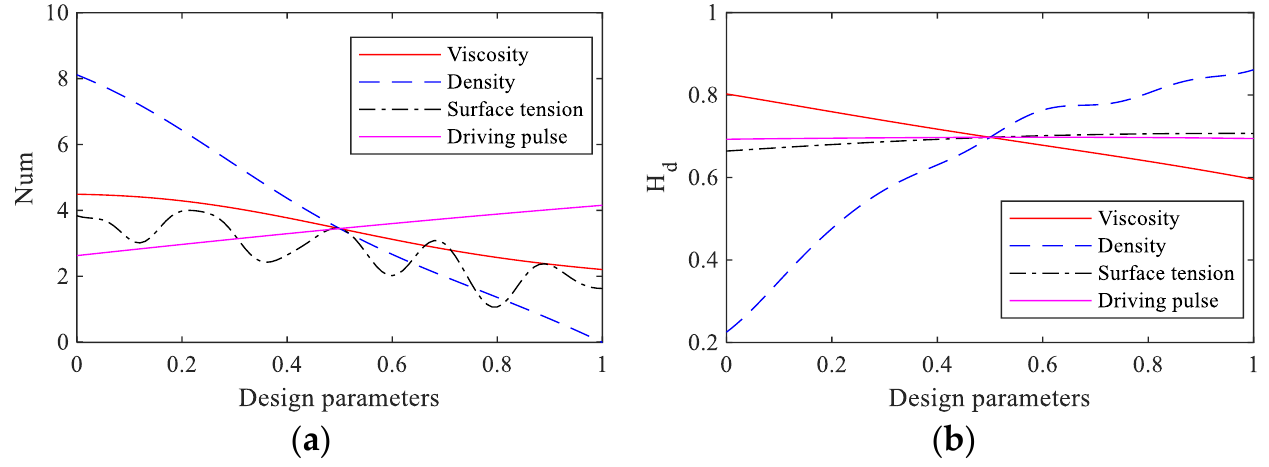
Figure 14. The design parameters influence trend. ( a ) Effect of design parameters on Hd. ( b ) Effect of design parameters on the number of satellite droplets.